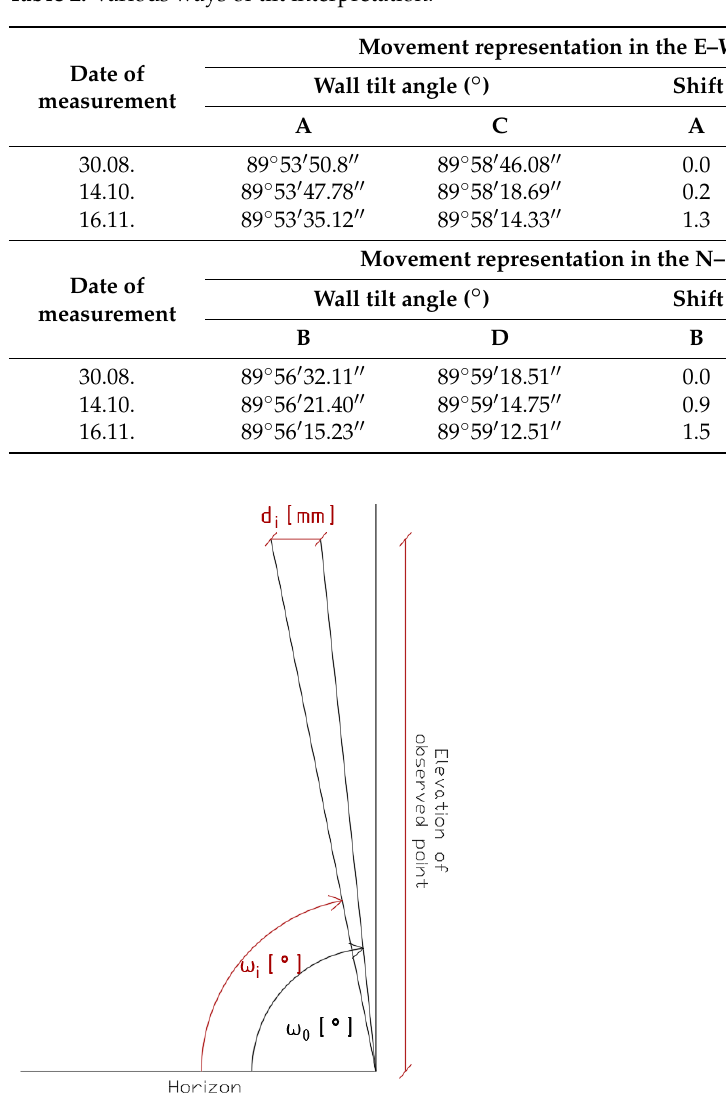
Figure 6. Graphical illustration of tilt